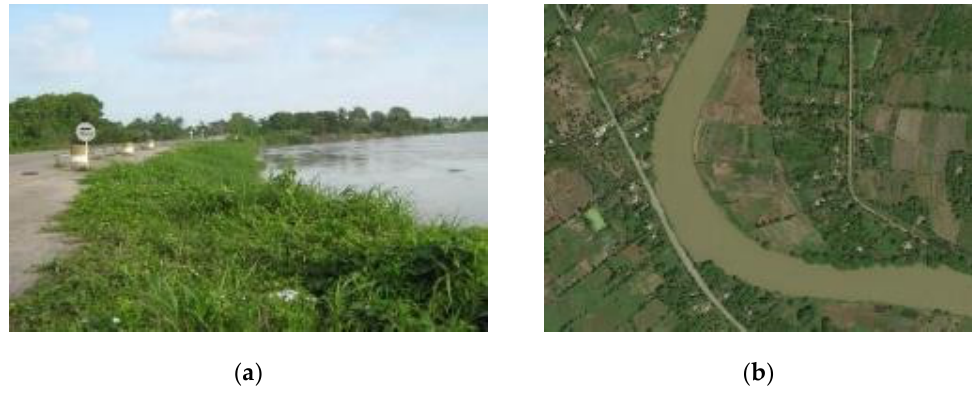
Figure 11. Sinú River, Trementino: ( a ) condition in March 2011, seven and a half years after installation; ( b ) condition in 2018, 13 years after installation (Hidroconsulta, 2011; ESRI, 2018 [11]).